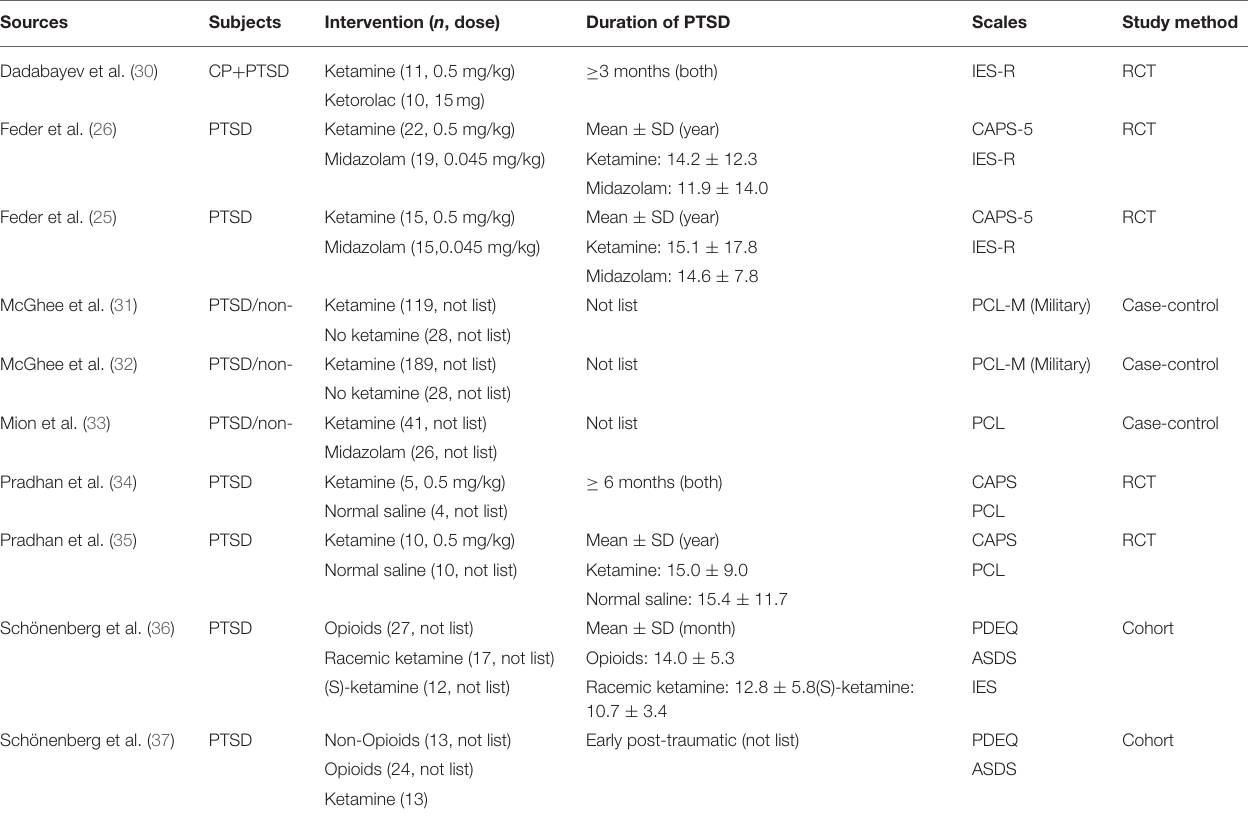
TABLE 1 | Included study characteristics, intervention, duration, scales, and study method. Sources Scales Study method